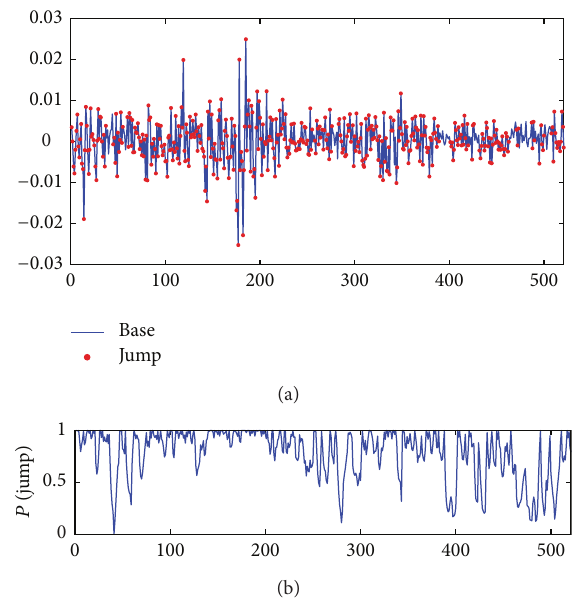
Figure 2: Calibration results for model (56) with two independent regimesfittedtotheSETindexlogprices.Thepricesjumpisdenoted by dots in the upper panel and the lower panel shows the conditional probability of beginning of the jump